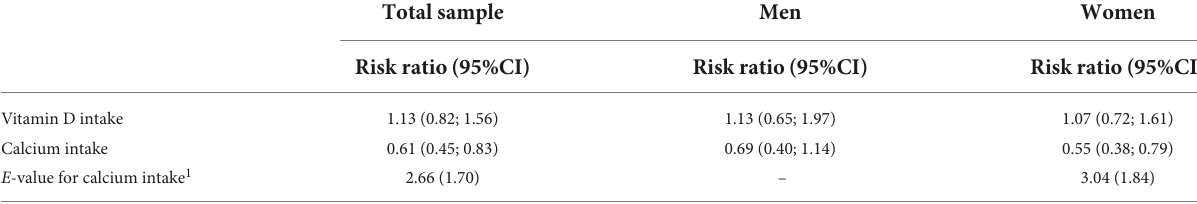
Estimatesgivenareriskratiosandrespective95%confidenceintervals.Analysesareshownforthetotalsample,aswellasstratifiedbysex. 1 The E -valuewascalculatedonlyforpositiveassociations.Thus,thereisnovaluesforvitaminDintake.The E